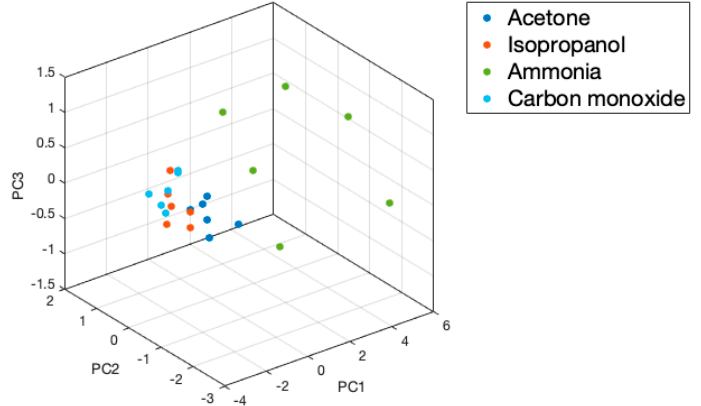
Figure 7. Principal component analysis (PCA) plot of RGO–metalloporphyrin-sensing response was obtained.